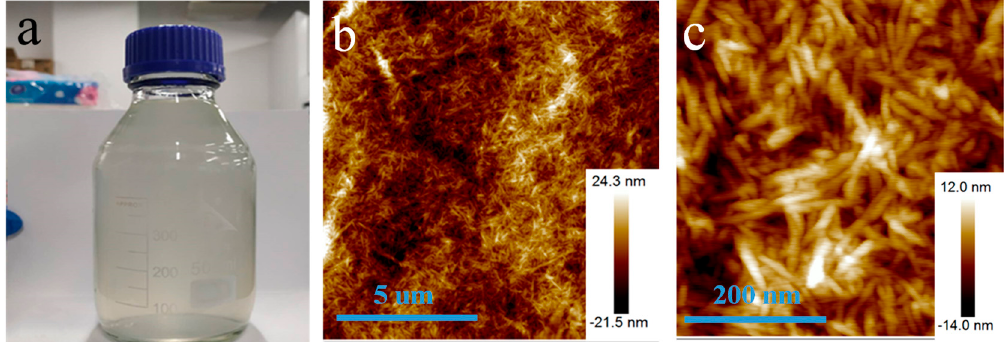
Figure 2. ( a ) The photo of a bottle of CNs aqueous dispersion, ( b ) a low magnification AFM image of CNs, and ( c ) a high magnification AFM image of CNs.